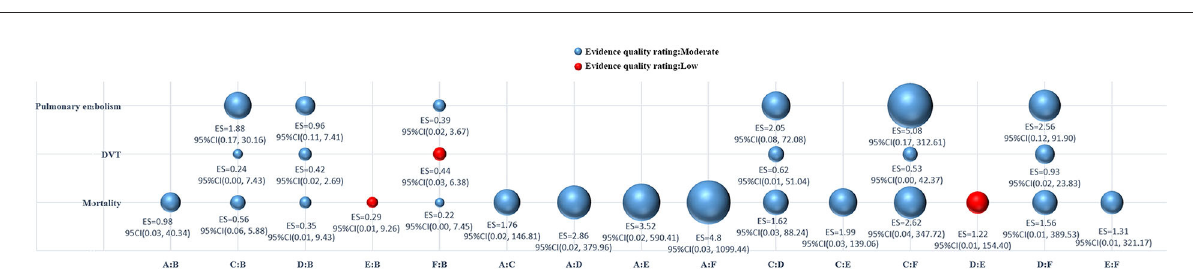
FIGURE2 Risk of bias assessment results of included studies.